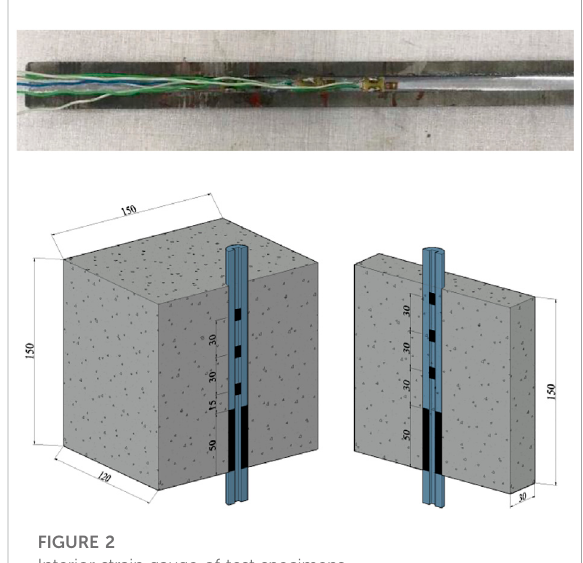
FIGURE 2 Interior strain gauge of test